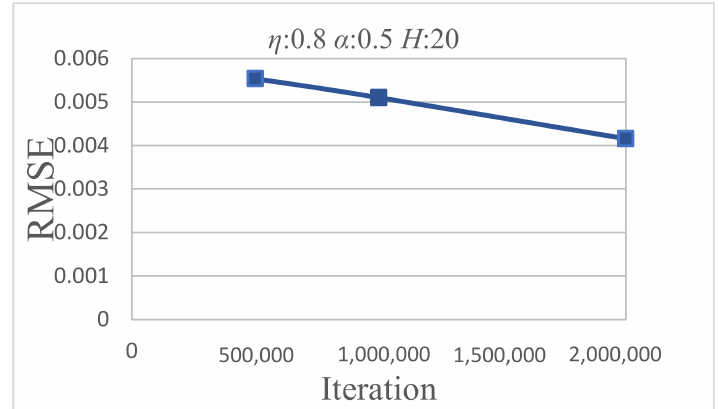
Figure 8. Iteration variables for RMSE.